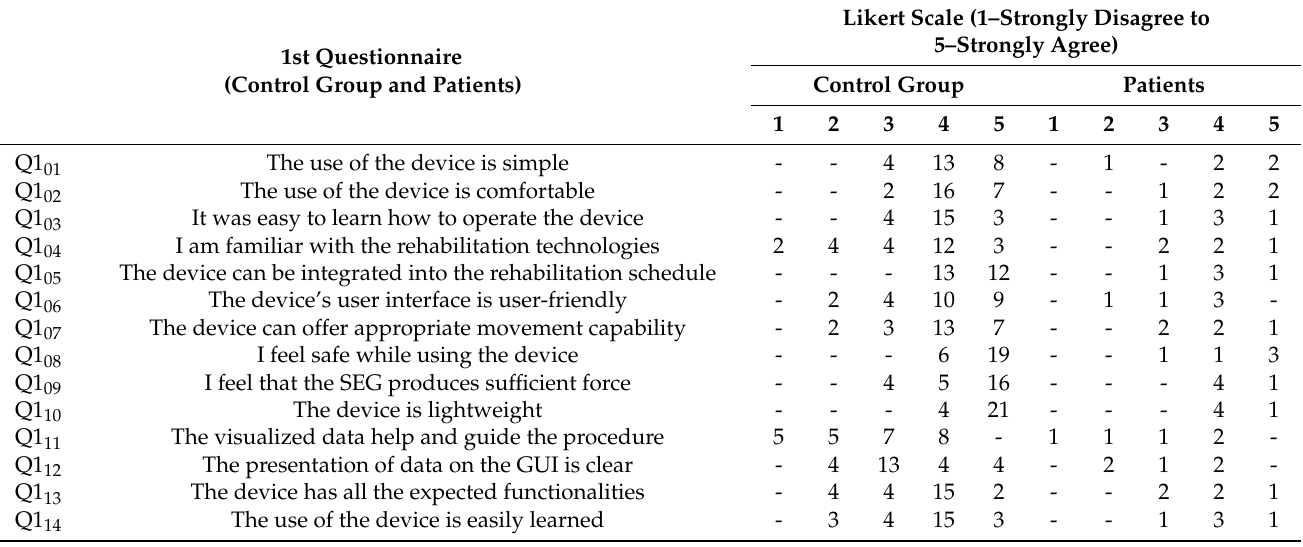
Table 3. The questions of the first questionnaire and the distribution of answers per question.